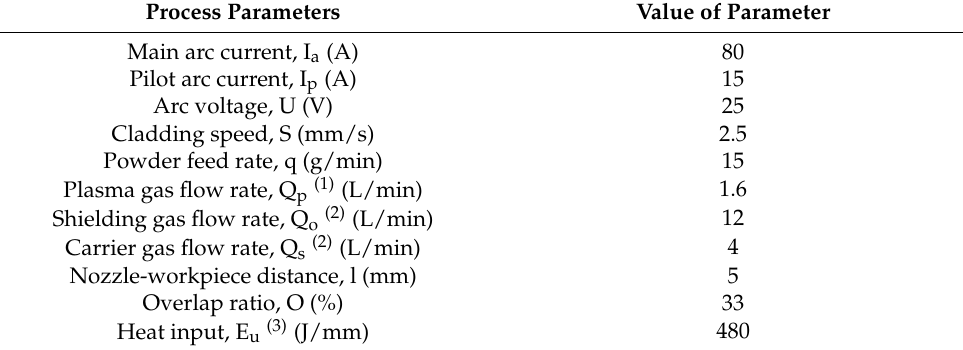
Table 3. Optimum processing parameters of robotic plasma powder transferred arc cladding of Co3+TiC+PD-W composite powder deposition on steel AISI